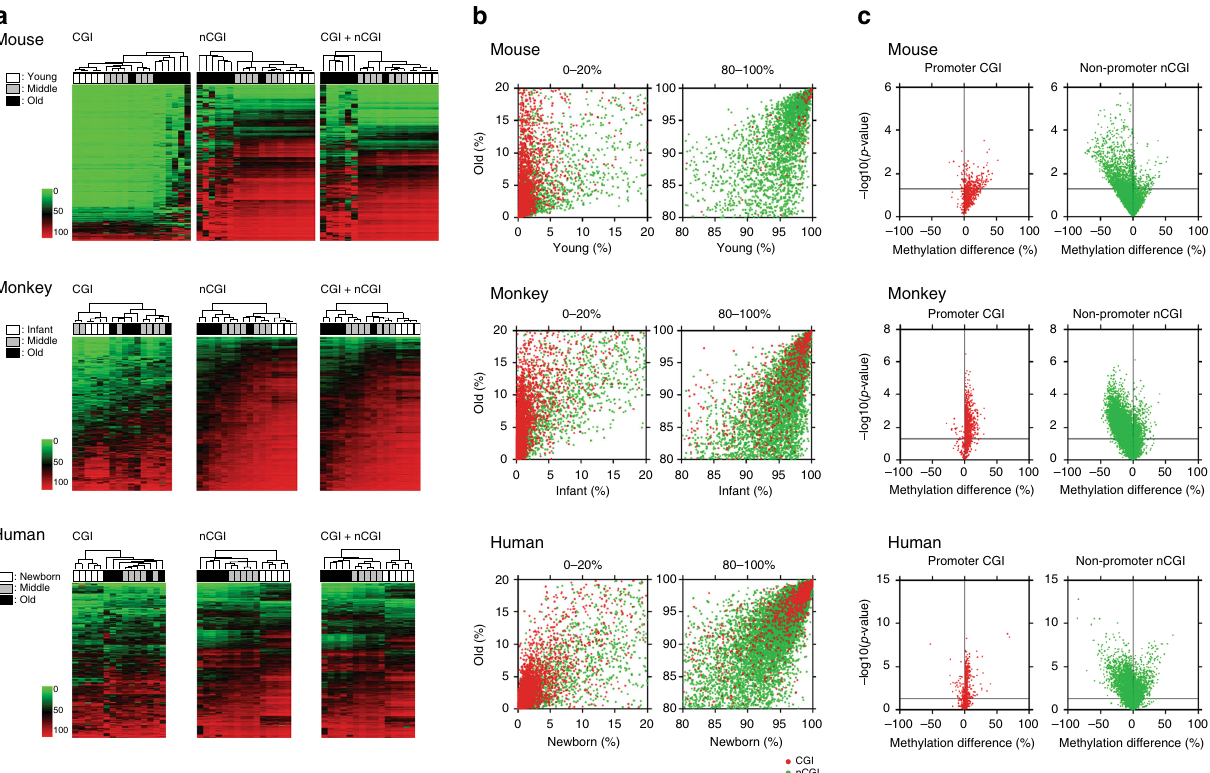
Fig. 1 DREAM DNA methylation analysis of whole blood DNA from different species. a Unsupervised hierarchical clustering analysis of CpG sites in CpG island (CGI), non-CGI, and all genomic regions. The green to red color scale indicates the methylation percentage. The color codes for age are shown on the left . b DNA methylation in old vs. newborn/infant/young. Average DNA methylation level of each CpG site in old individuals ( y axis) is plotted against that in newborn/infant/young individuals ( x axis). The red and green dots represent CGI and non-CGI CpG sites, respectively. The low range (0 – 20%) and high range (80 – 100%) of methylation status are shown. c Volcano plots show CpG sites differentially methylated between old and newborn/infant/young. Plots on left are sites in promoter CGI ( red ) and on right site are sites in non-promoter non-CGI ( green ). The promoter region is de fi ned as – 1 kb ≤ TSS ≤ + 500 bp. The methylation difference between old and newborn/infant/young is shown on the x axis, the p -value (in – log10 scale) on the y axis. The horizontal line indicates p -value at